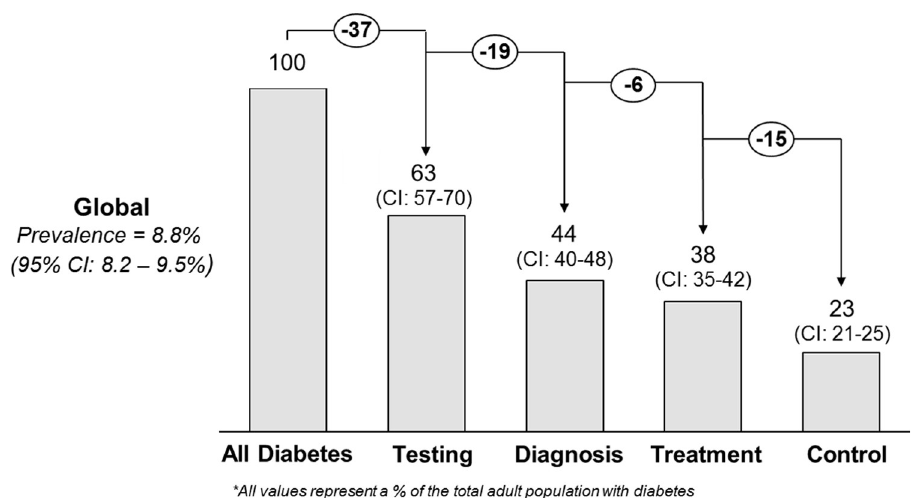
Fig 1. The global diabetes cascade of care in population-based surveys conducted in 28 low- and middle-income countries between 2008 and 2016.